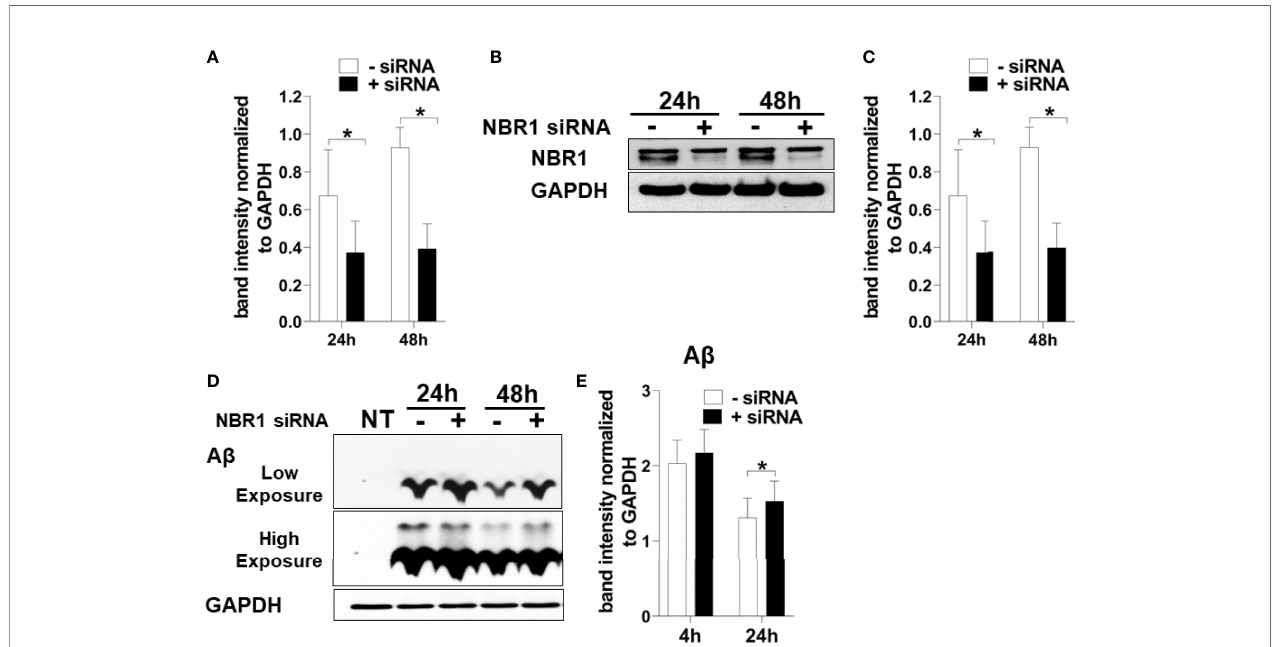
FIGURE 4 | NBR1 is required for A b (1-42) degradation. (A) Nbr1 relative copy number in human microglial cell line (HMC3) treated with 50nM Nbr1 siRNA or non- targeting negative control for 24 and 48h (n = 4). Statistical analysis performed using paired two tailed Student ’ s t-test. (B) NBR1 and GAPDH immunoblot of HMC3 cells treated as in (A) (n = 4). (C) Densitometry analysis of immunoblots represented in (B) . Data represent mean ± SEM (n = 4). Statistical analysis performed using paired two-tailed student ’ s t-test. (D) Immunoblot for A b and GAPDH in HMC3 microglia transfected as in (A) for 24h and treated with 1 µM of fi brillar A b (1-42) for either 4 or 24h to assess the course of A b degradation. (E) Densitometry analysis of immunoblots represented in (D) . Data represent mean ± SEM (n = 4). Statistical analysis was performed using matched two-way ANOVA. *p ≤